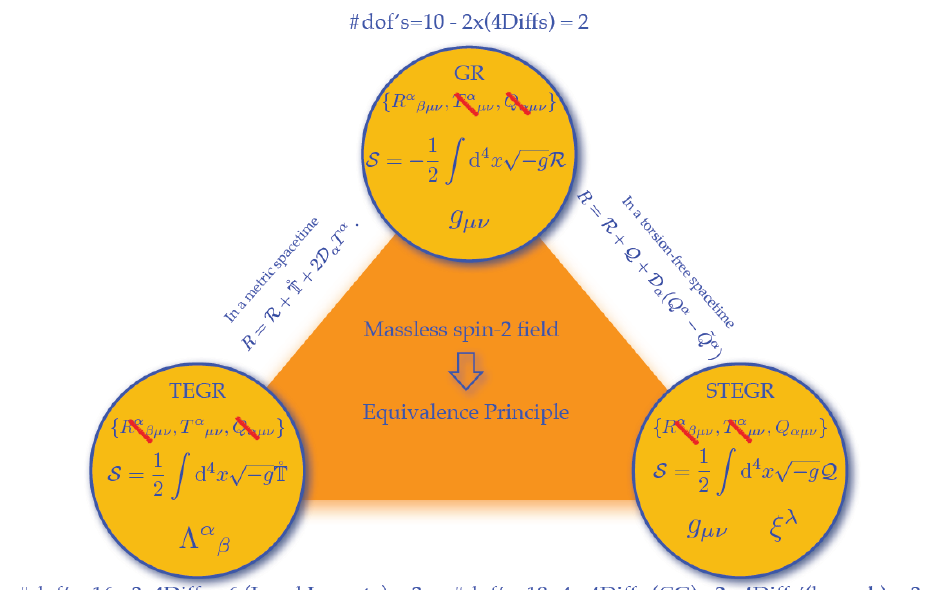
Figure 2. This figure summarises the three alternative gravitational descriptions of gravity together with its main properties. In the GR description, the fundamental object is the metric tensor g µν , the spacetime is curved, but metric-compatible and torsion-free and the 4 Diffs symmetry reduce the DOFs from 10 to 2. The TEGR has the inertial connection parameterised by Λ α β fundamental object, which generates torsion, but the connection and the non-metricity are trivial. Diffs plus the local Lorentz symmetry reduce the 16 independent components of Λ α β to 2. Finally, the STEGR contains the metric g µν and ξ α as fundamental elements. In this case, ξ α generates a flat and torsion-free connection and only the non-metricity piece is left. Furthermore, ξ α can be fully removed by a suitable choice of coordinates (the coincident gauge) leaving a trivial connection. In that gauge, the presence of a second Diffs symmetry realised up to boundary terms reduce the number of DOFs to two. At the heart of these equivalences lies the fact that gravity describes a theory for an interacting massless spin-2 particle, whose consistency requires the equivalence principle and, thus, the possibility of describing it in geometrical